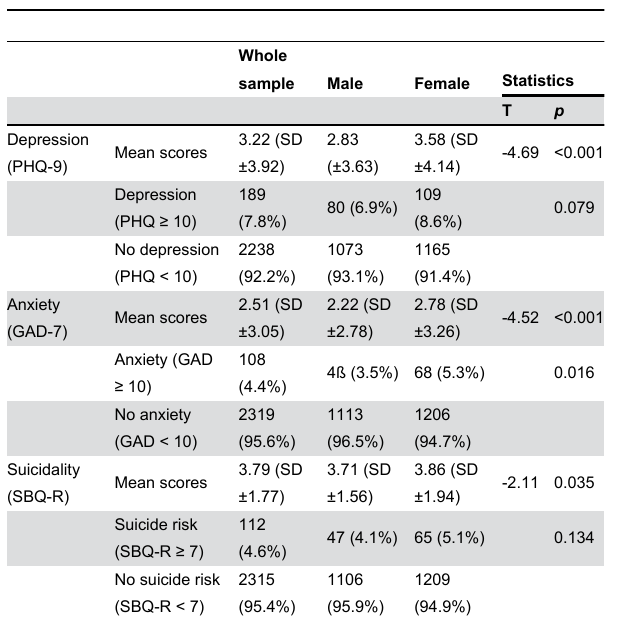
Table 4. Logistic regression analysis of suicide risk (whole sample, n = 2427).